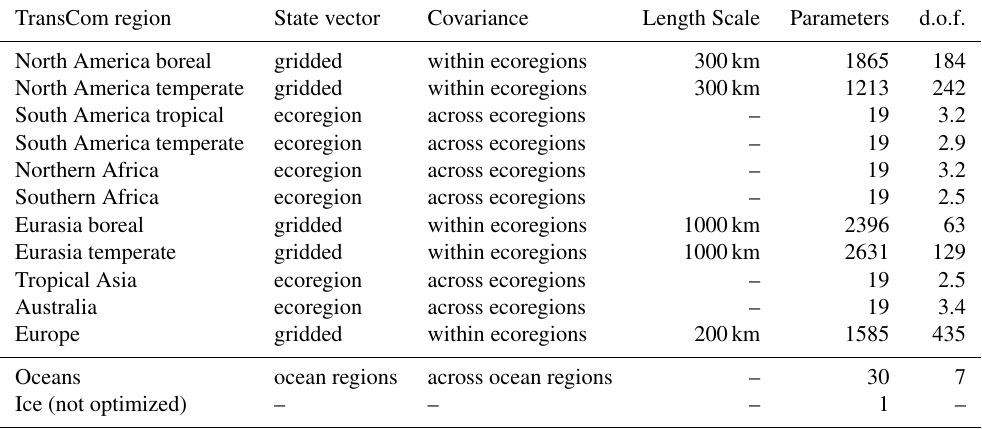
Table 1. Gridded state vector setup per TransCom land region and for global ocean regions, including details on the covariance, length scale, number of parameters and degrees of freedom (d.o.f.).